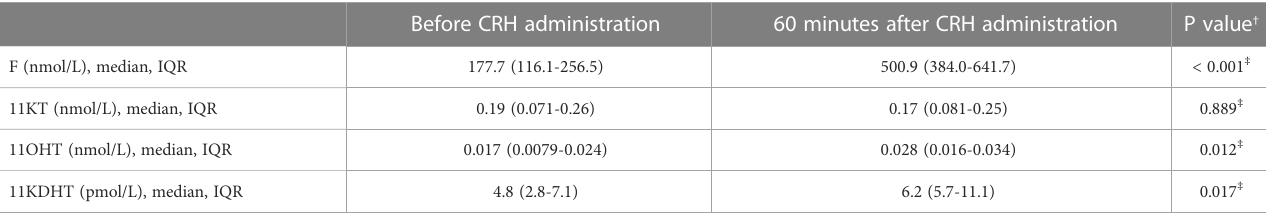
TABLE 4 Steroid hormone values before and at 60 minutes after CRH administration (Study 2).